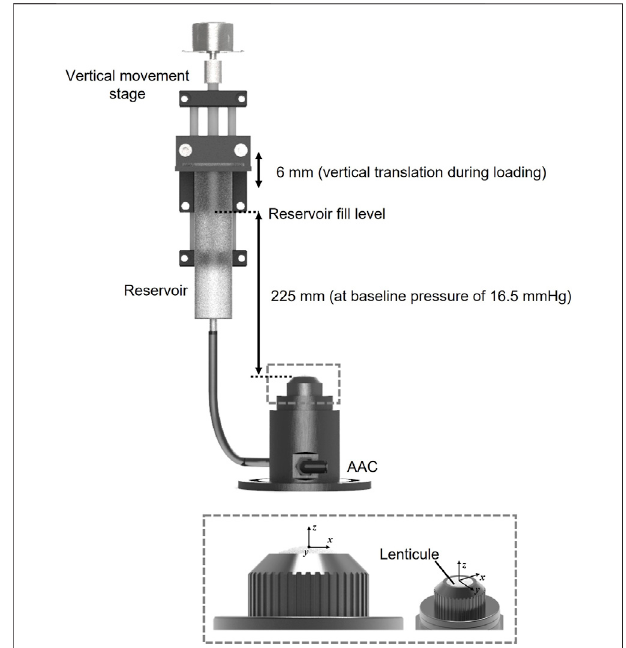
FIGURE 1 | Diagram of loading system con fi guration and the custom arti fi cialanteriorchamber(AAC)with7 mmaperture intowhichlenticuleswere